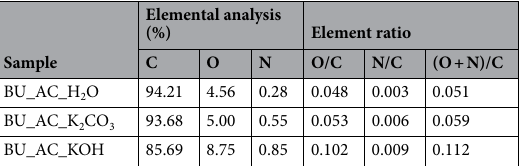
Table 1. Surface atomic ratio and compositions of activated carbon